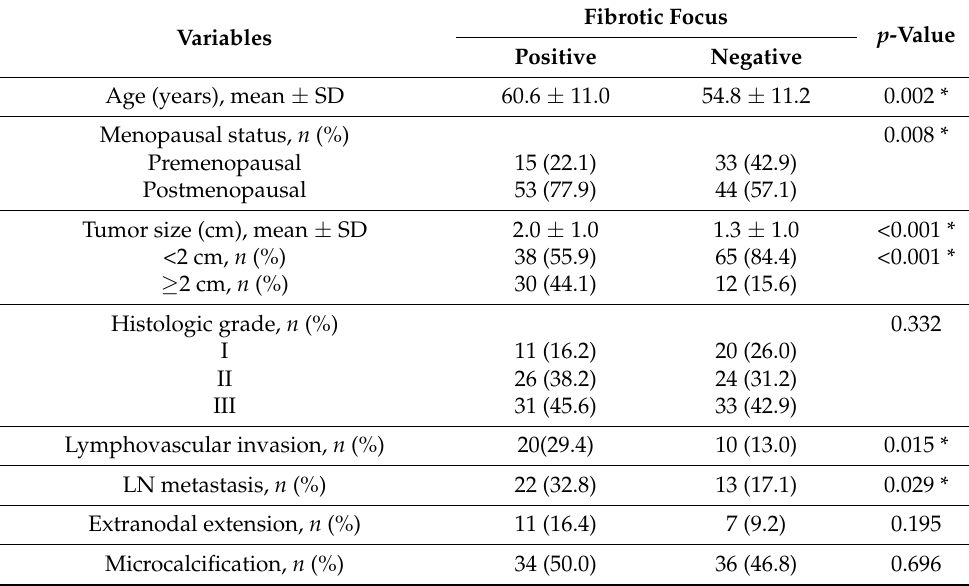
Table 4. Association between fibrotic focus and clinicopathological characteristics of breast